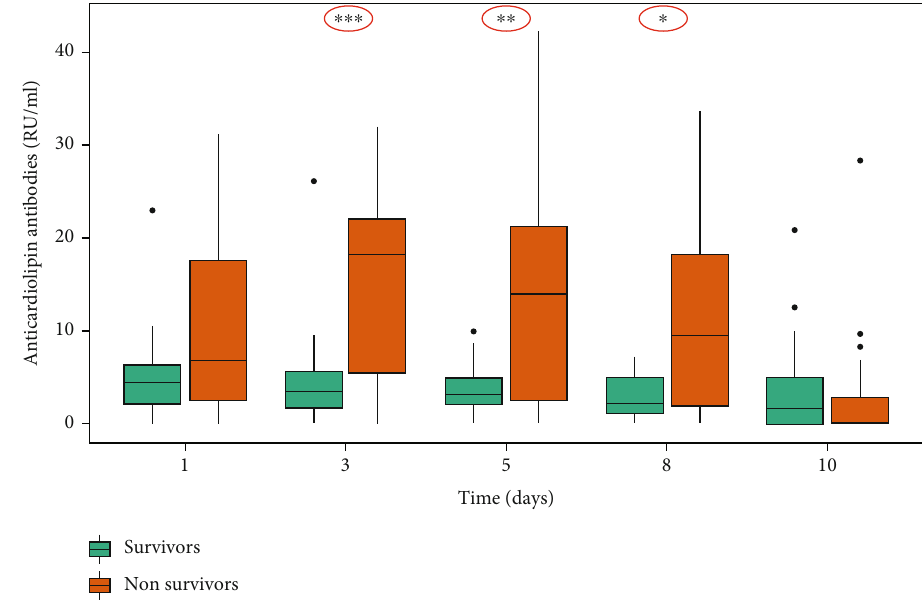
Figure 1: Association of anticardiolipin antibodies (aCL) with in-hospital